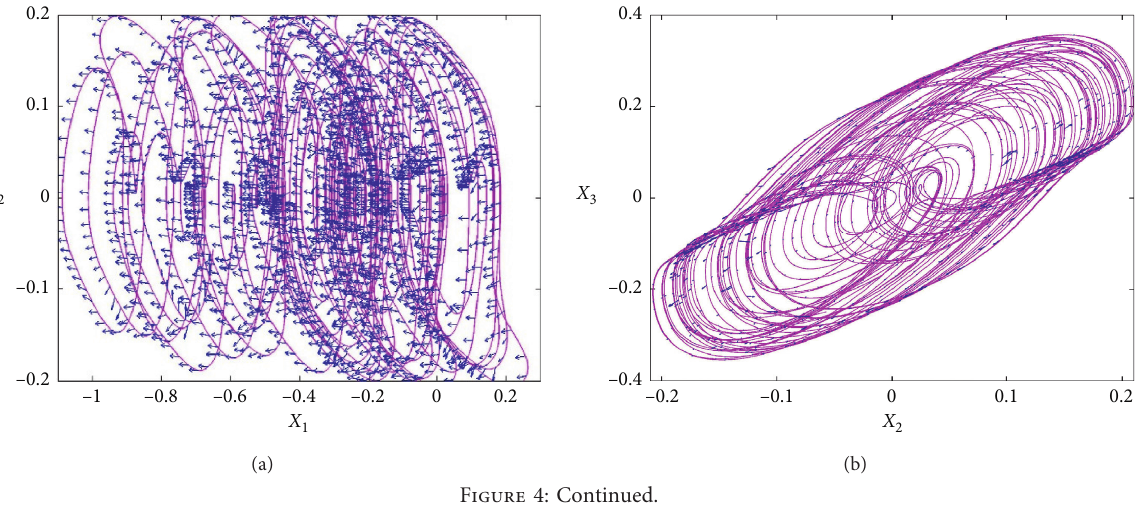
− x plane; (b) 1 2 − x 4 5